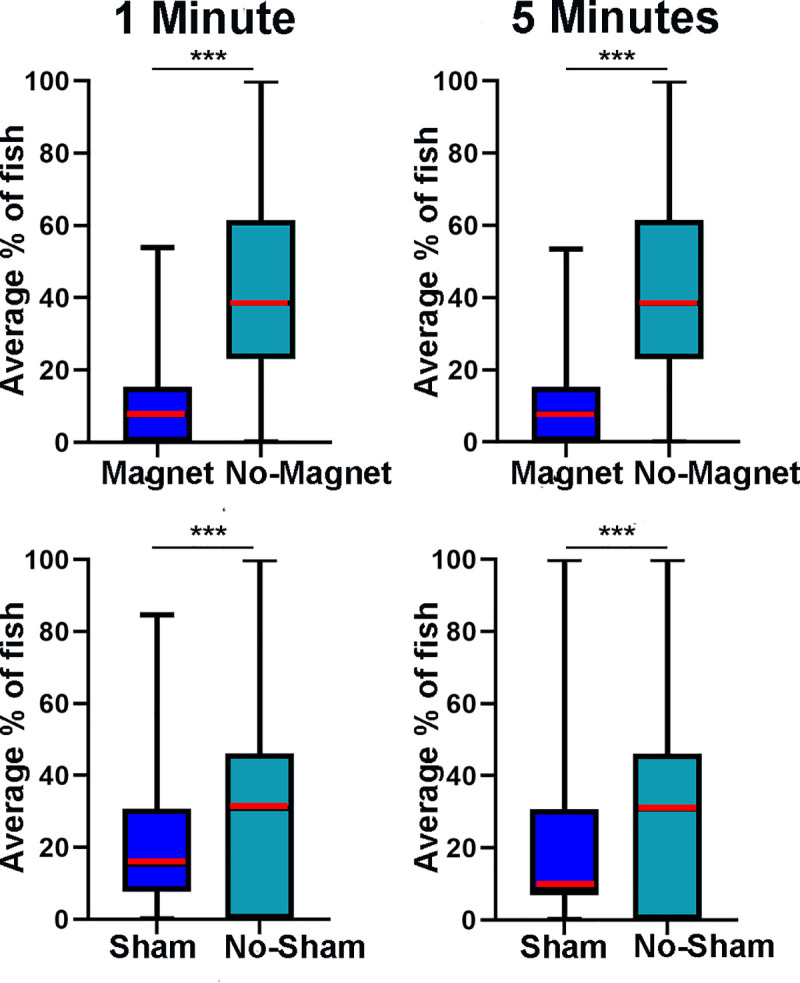
Constant location of stimulus results.The average percentage of the fish school (n = 13) in sham/magnet (Arm 1) compared to the merged data from no-sham/magnet arms (Arm 2 & 3). There is significantly less fish in the arm with magnet present compared to the pooled no-magnet arms on average. There is also significantly more fish in the no-sham arms compared to sham arm (*** = p < .0005, Mann-Whitney U Test). This is a Spear Box Plot with the box showing 25% to 75% interquartile range and median represented as a red line, whiskers show minimum and maximum values. Magnet 1 minute: median = 7.69%, IQR = 15.39%; No Magnet 1 Minute: median = 38.46%, IQR = 38.46%; Magnet 5 minutes: median = 7.79%, IQR = 15.39%; No Magnet 5 Minutes: median = 38.46%, IQR = 38.46%; Sham 1 minute: median = 15.39%, IQR = 23.08%; No Sham 1 minute: median = 30.77%, IQR = 46.15%; Sham 5 minutes: median = 7.69%, IQR = 23.08%; No Sham 5 minutes: median = 30.77%, IQR = 46.15%.